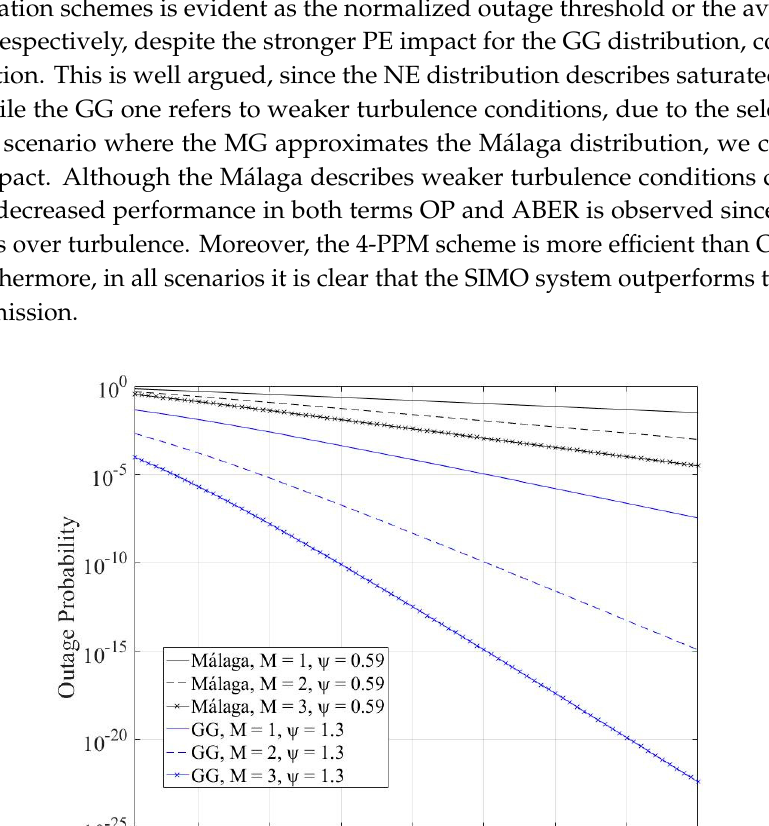
Figure 2. OP performance versus the normalized outage threshold for NE case.